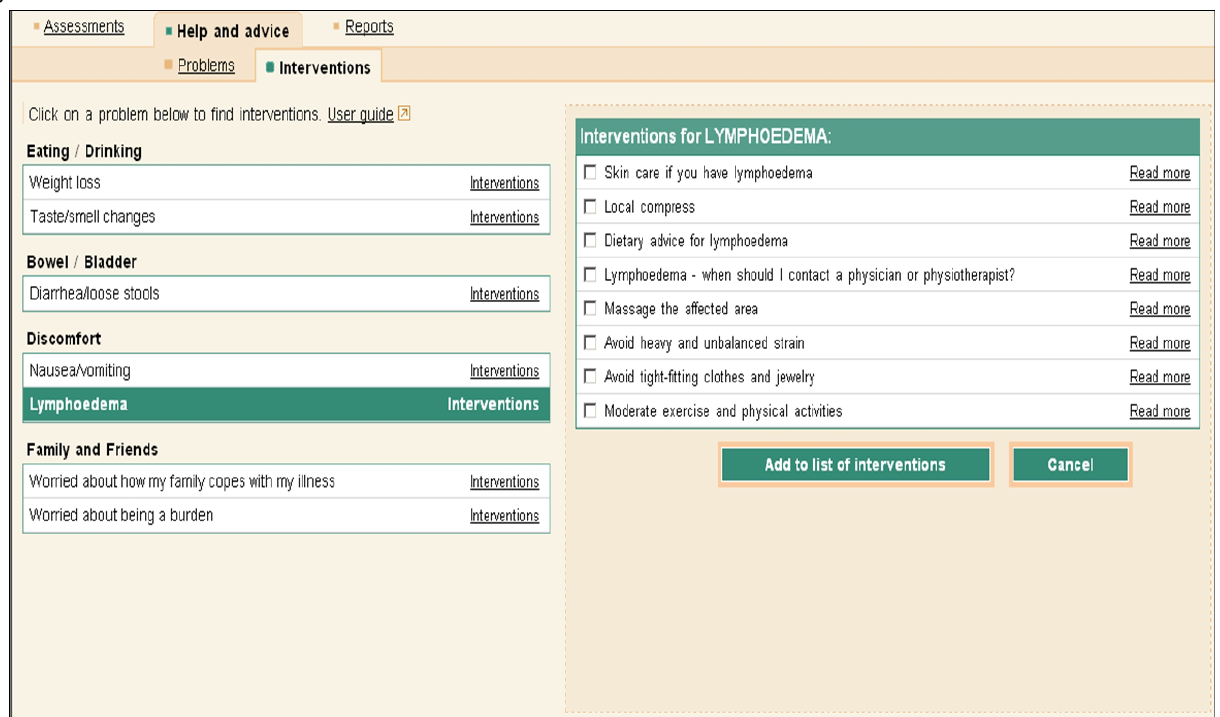
Figure 2. Screenshot of the results of an assessment and the associated